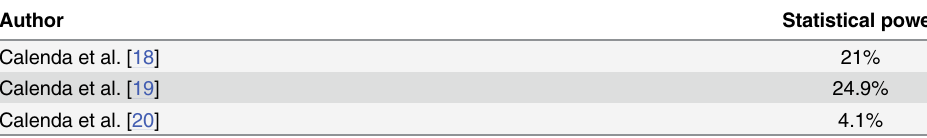
Table 3. Post-hoc analysis of statistical